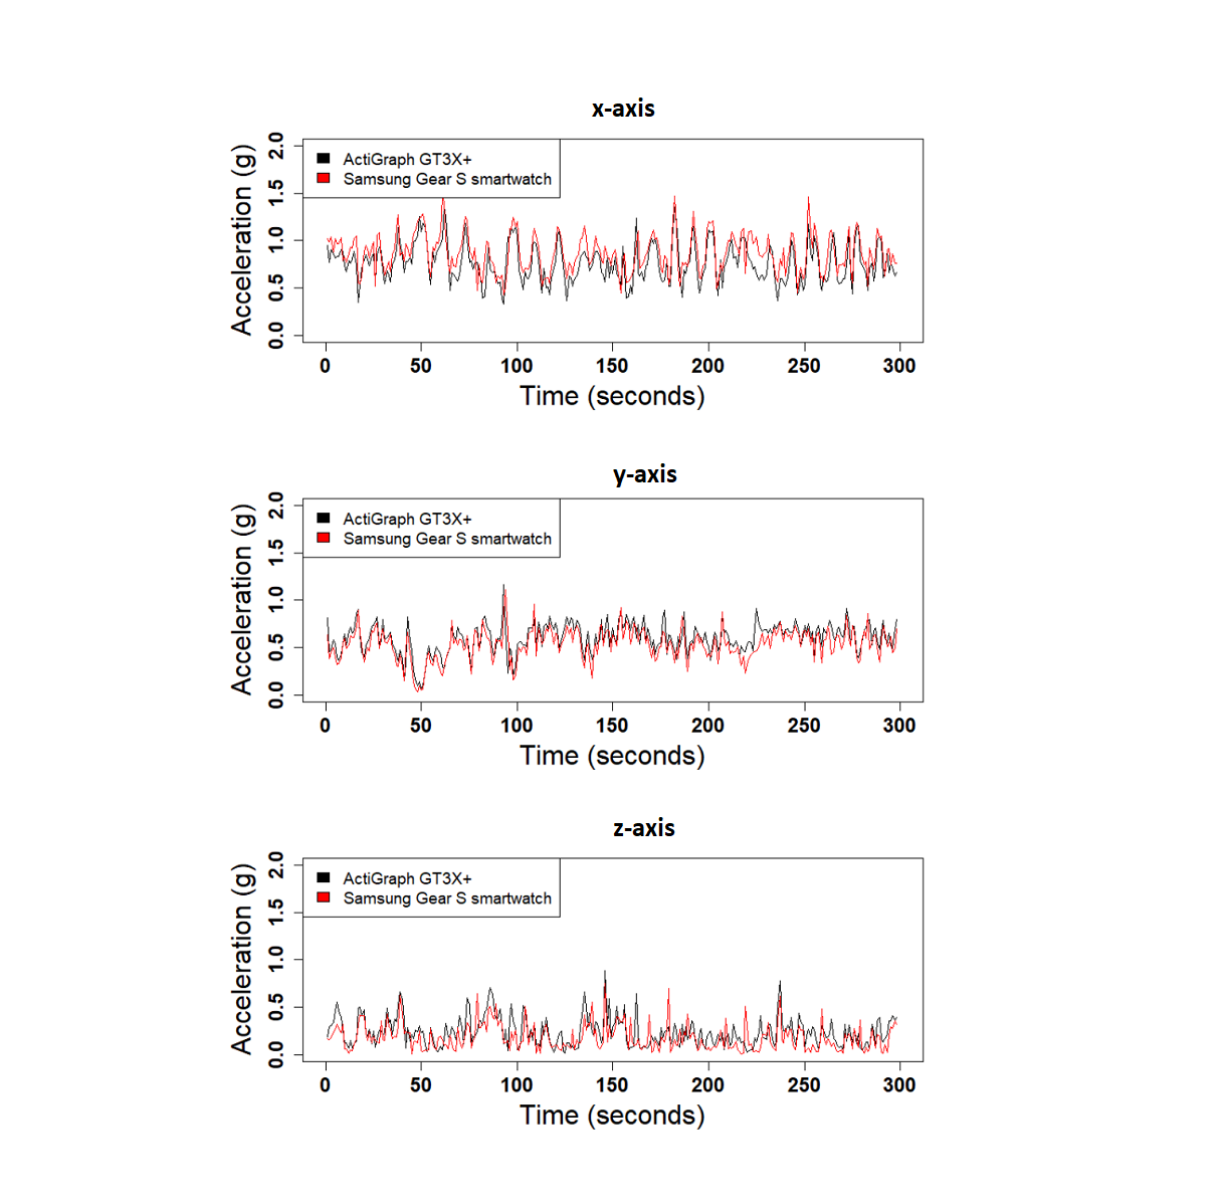
Figure 7. Acceleration data from mopping (complex activity) for all 3 axes.